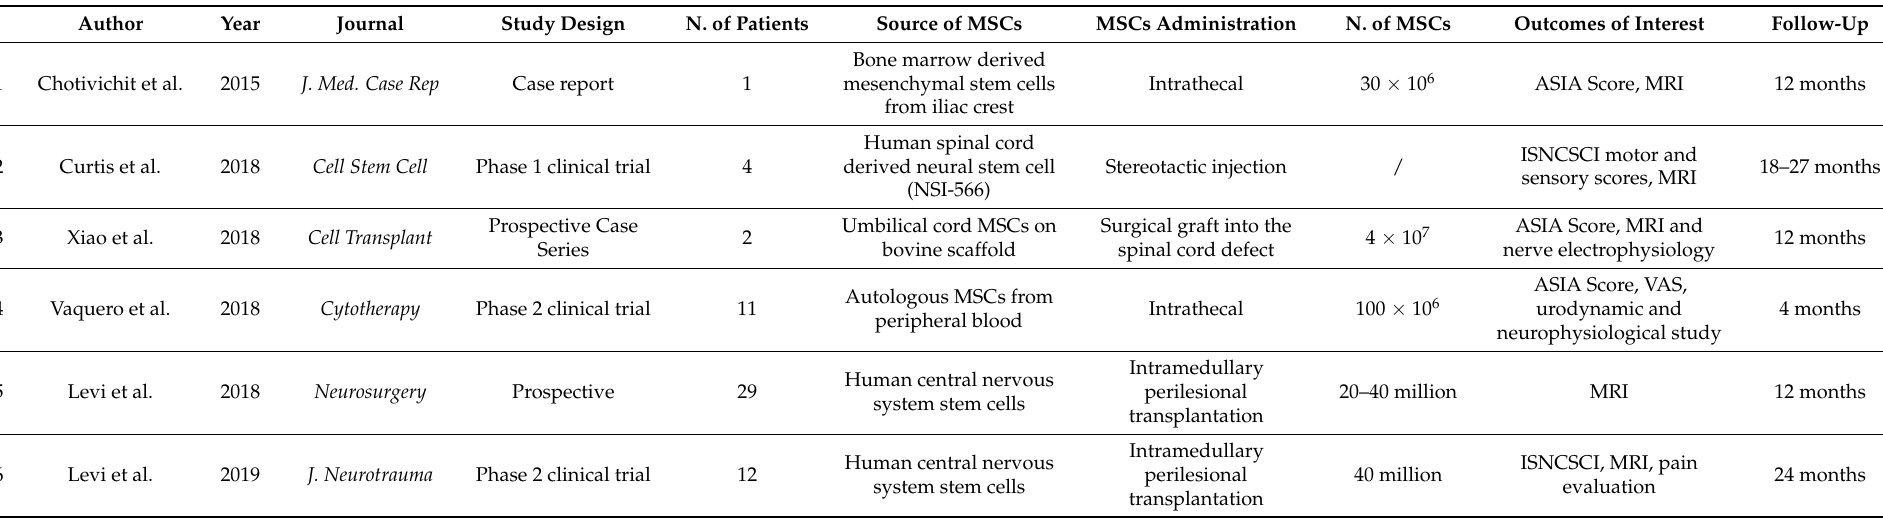
Table 2. Summary of the key data of the available studies. ASIA: American Spinal Cord Injury Association; ISNCSCI: International Standards for Neurological Classification of Spinal Cord